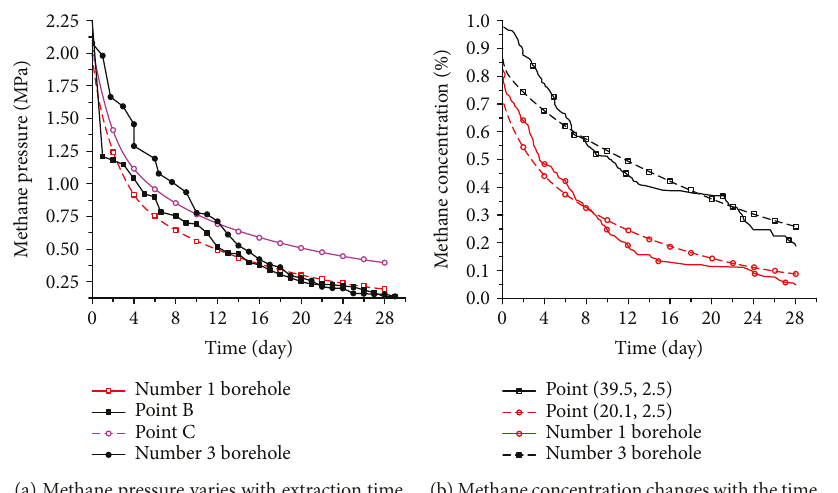
Figure 8: Comparison of fi eld methane pressure and numerical model